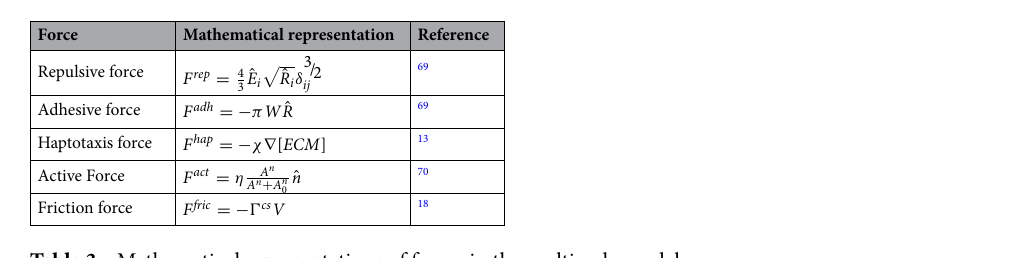
Table 3. Mathematical representations of forces in the multiscale